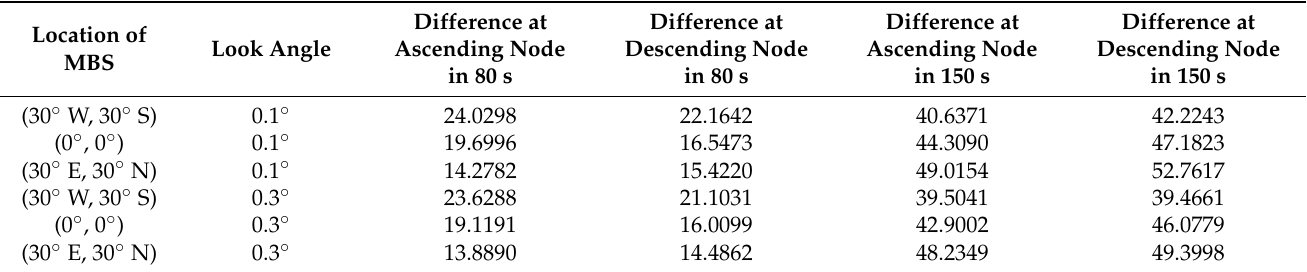
Table 3. The maximum difference in the delay range (m) (i.e., the maximum value between the downlink path and the uplink path) for various MBS at one approximate ascending node (i.e., 11:01:01 15 January 2001) and one approximate descending node (i.e., 22:01:01 2 January 2001), with the synthetic aperture times being about 80 s and 150,